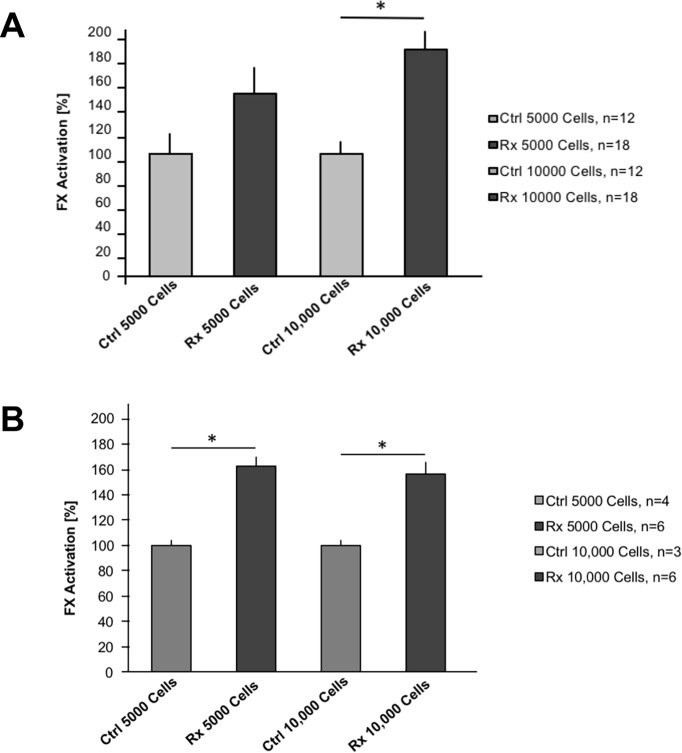
Factor X activation assay in the presence of human endothelial cells or human sarcoma cells.(A) Different numbers of human endothelial cells (HUVEC; 5000 or 10,000 cells per assay) were tested without or with previous irradiation in a validated FX activation assay as described in the Methods section with identical amounts of tTF-NGR and all other test components present. Results with cells without previous irradiation (Ctrl, control) were given as 100%. Results with cells after irradiation (Rx, 4 Gy) are represented by the black columns. Results of 3 independent experiments with total numbers of assays given as n are shown with mean values and standard error (SE) bars. Asterisk represents comparisons with two-tailed p values <0.05 (5000 cells: control vs. 4 Gy, p = 0.074; 10,000 cells: control vs. 4 Gy, p = 0.0001). (B) Different numbers of human sarcoma cells (HT1080) were tested in the FX activation assay as described for (A). Results of FX experiment with total numbers of assays given as n are shown with mean values and standard error (SE) bars. Asterisks represent comparisons with two-tailed p values <0.05 (5000 cells: control vs. 4 Gy, p = 0.0001; 10,000 cells: control vs. 4 Gy, p = 0.00461).